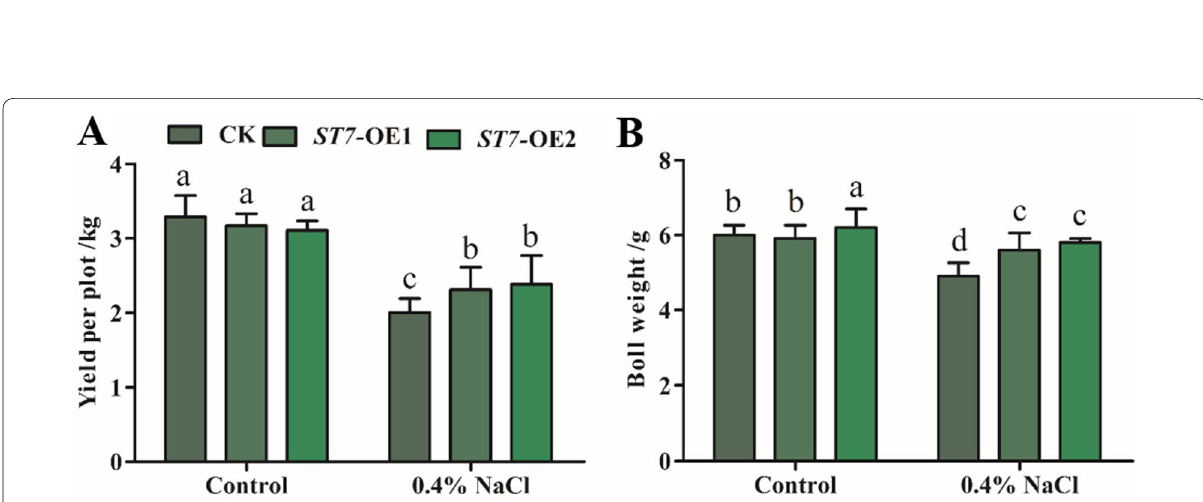
Fig. 4 ThST7 overexpression improved cotton yield in saline field. A Yield per plot of wild type, ST7 -OE1 and ST7 -OE2 lines in normal soil conditions (0.1% NaCl) and saline soil with 0.4% NaCl. B Average boll weight of the CK and ST7 -OE lines as in A